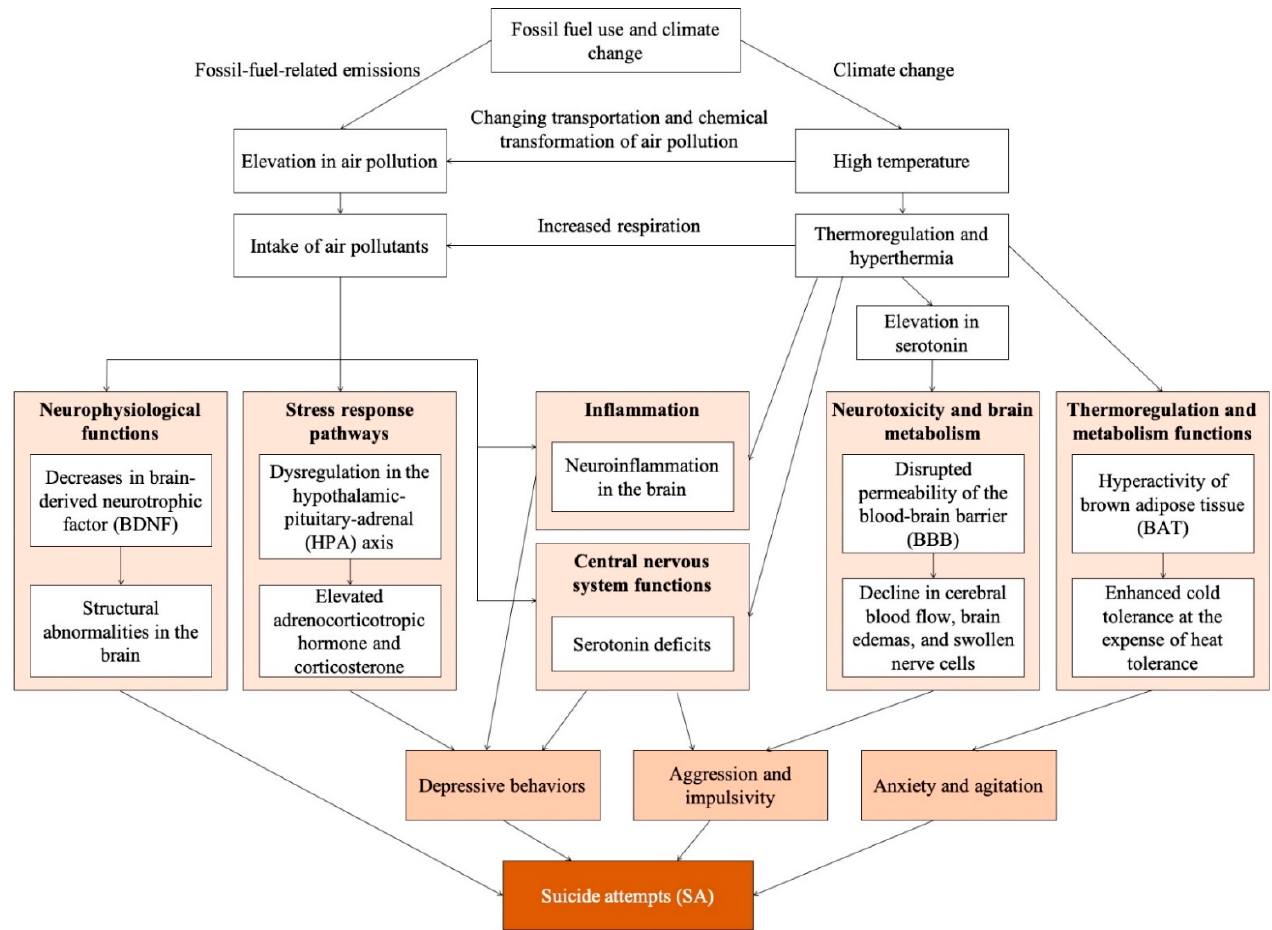
Figure 1. Main putative pathogenic mechanisms of exposure and reciprocal relationships for air pollution, high temperature, and suicide risk.